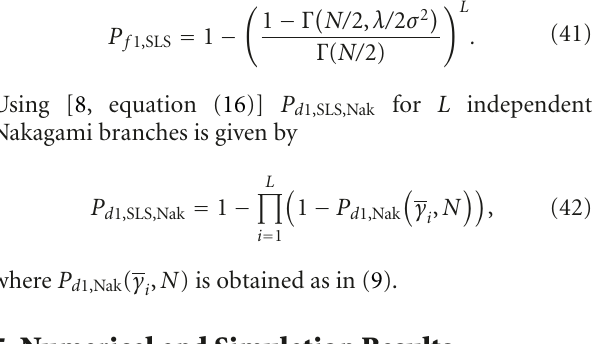
Figure 2: P D versus P F for K = 2, for di ff erent Nakagami fading, γ = 10 dB.